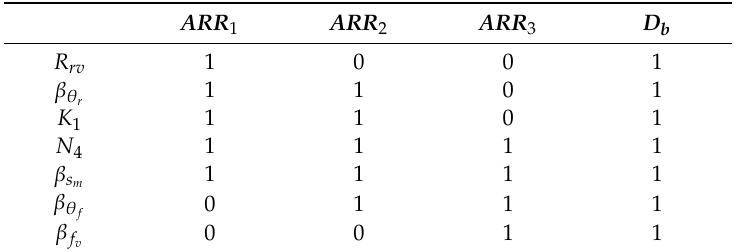
Table 2. Fault signature matrix (FSM) of the electric